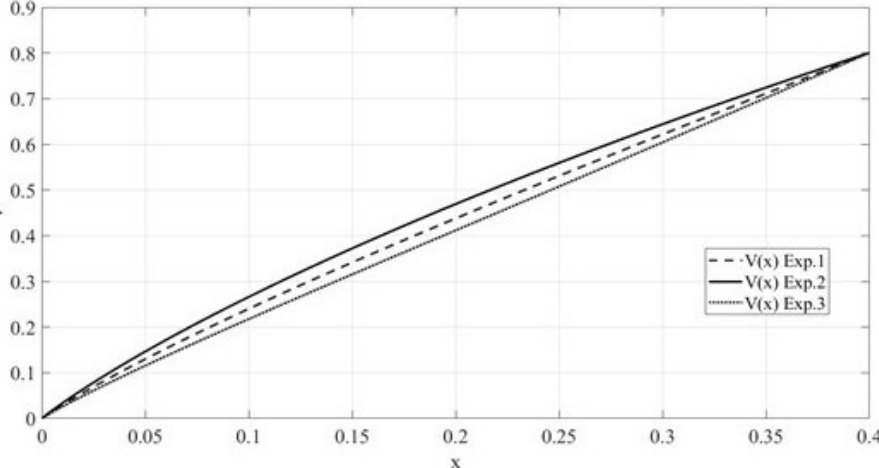
Figure 6. The limit-state graphs under the conditions of Examples